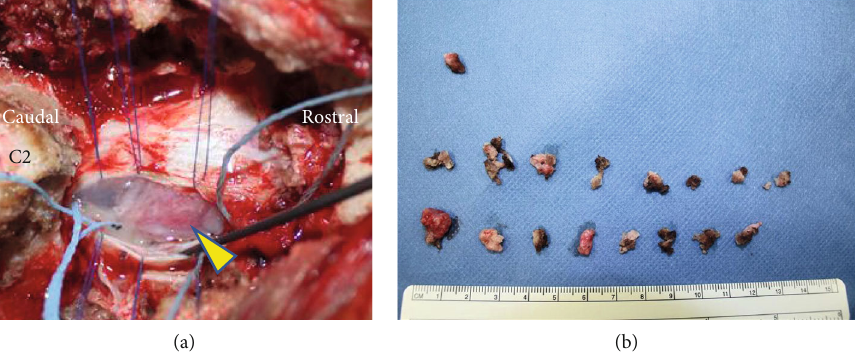
Figure 3: (a) A mass was identi fi ed after durotomy (arrowhead). (b) The tumor was resected in a piecemeal